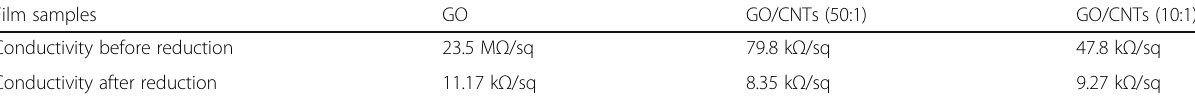
Table 1 Electrical conductivity of GO and GO/CNTs with different mass ratios before and after electrochemical reduction